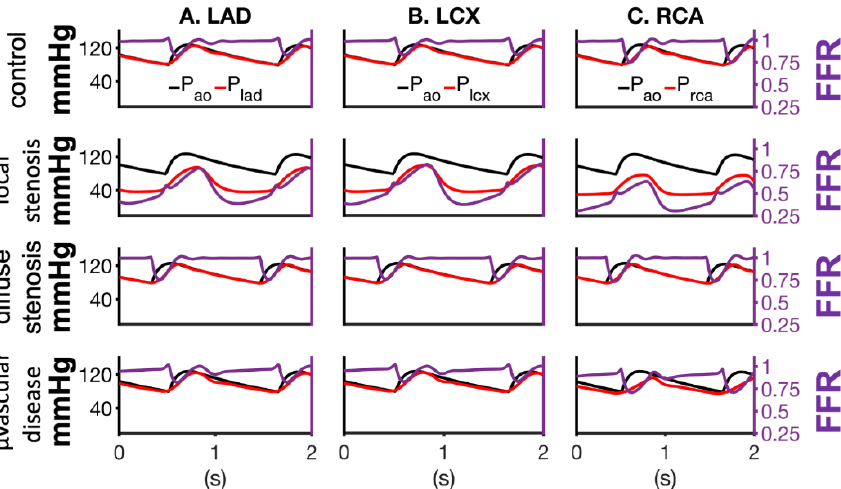
Figure 2. Pressure profiles and FFR in the LAD (column A ), LCX (column B ), and RCA (column C ). In all columns, top row shows non-stenosed model behavior, second row shows the result of focal stenosis ( 𝛼 = 90%) , and third row shows the result of downstream microvascular disease in the absence of focal stenosis ( α = 100%; (cid:101) = 2.33 ) . In all panels, black lines and axis represent aortic pressure (proximal pressure) while red lines and axis represent the pressure of vessel of interest (distal pressure). Time dependent FFR is shown as orange dashed lines.